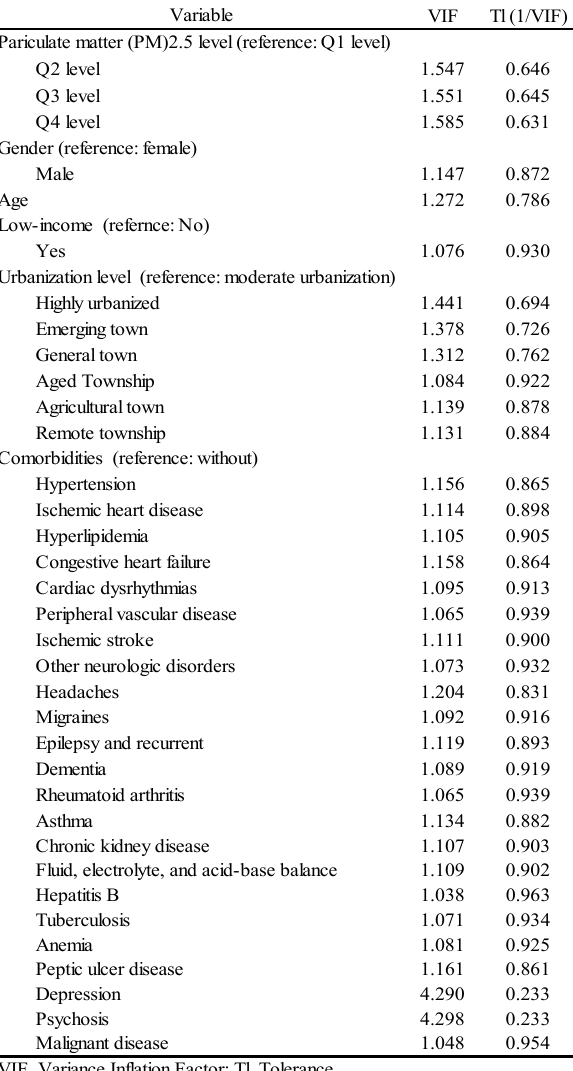
Figure 2. The standard (multiple) linear regression analysis model for collinearity diagnosis. As shown in Figure 3, after adjustment for gender, age, urbanization level, income level and comorbidities, statistically significant differences were noted; the OR for PM2.5 ex- posure concentration and glaucoma risk was 1.013 (95% CI: 1.006–1.020) for Q1, 1.004 (95% CI: 1.001–1.007) for Q3, and 1.003 (95% CI: 1.001–1.004) for Q4. Statistically significant differences were noted for individuals in Q2 (OR, 0.998 [95% CI: 0.994–1.003]). The ROC curve for predicting glaucoma had an AUC of 0.663 (95% CI: 0.618, 0.707) in diabetes patients.